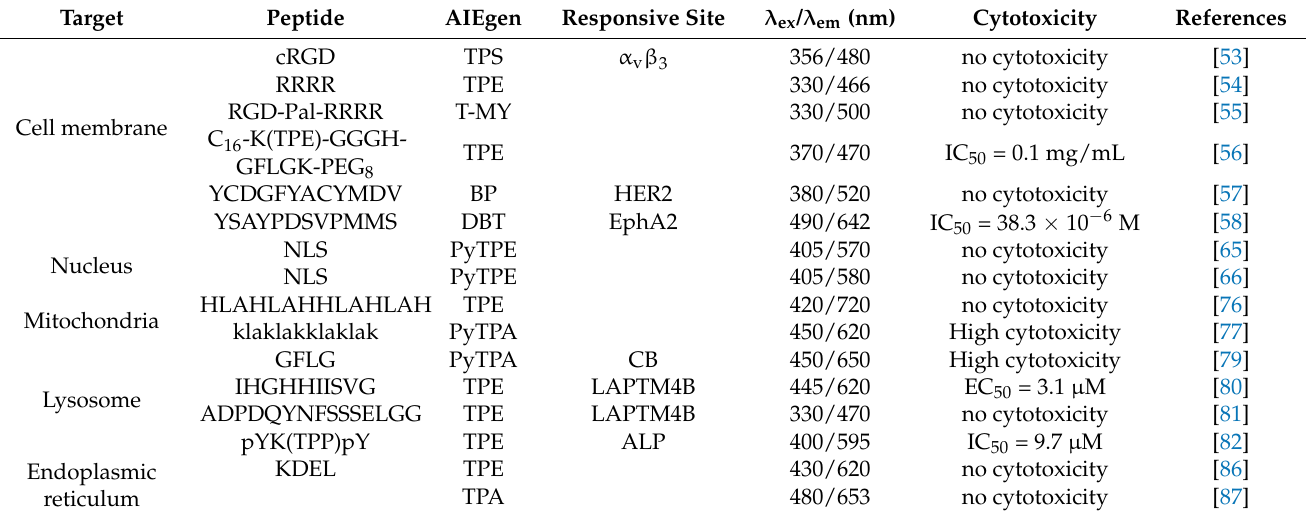
Table 1. Summary of AIEgen-peptide bi